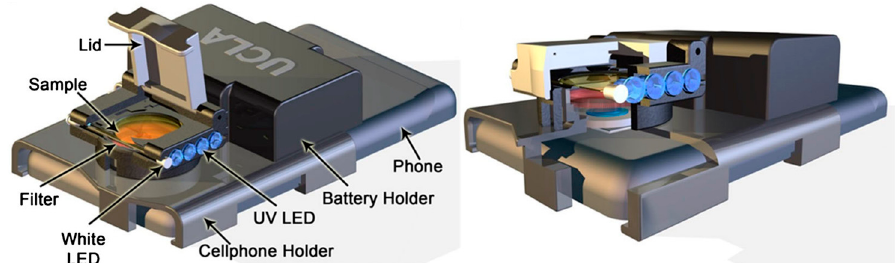
Figure 2. Schematic overview of the cellphone attachment for fluorescence diagnostics developed by Ludwig et al. [14]. Adapted with permission of Springer.